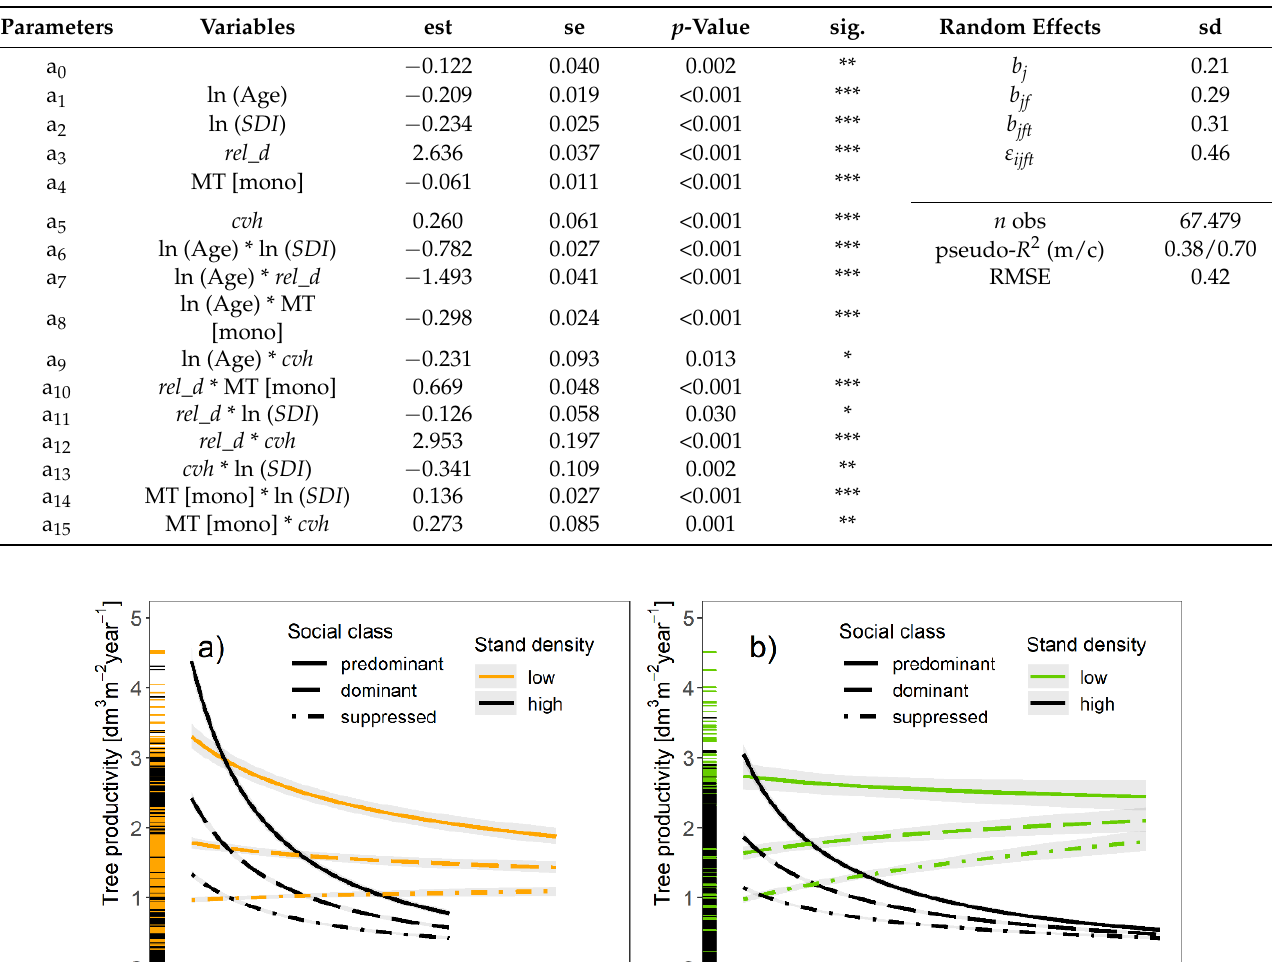
Table 6. Results of the linear mixed effects model on individual tree productivity (Equation (10)); mixed stands (reference); est—estimates, se—standard errors, p -values and significance levels *** <0.001, ** <0.01, * <0.05, ns for the fixed effects; sd—standard deviations are shown for the random effects; n obs—number of observations; pseudo- R 2 m—marginal/c—conditional; RMSE—root mean square error.